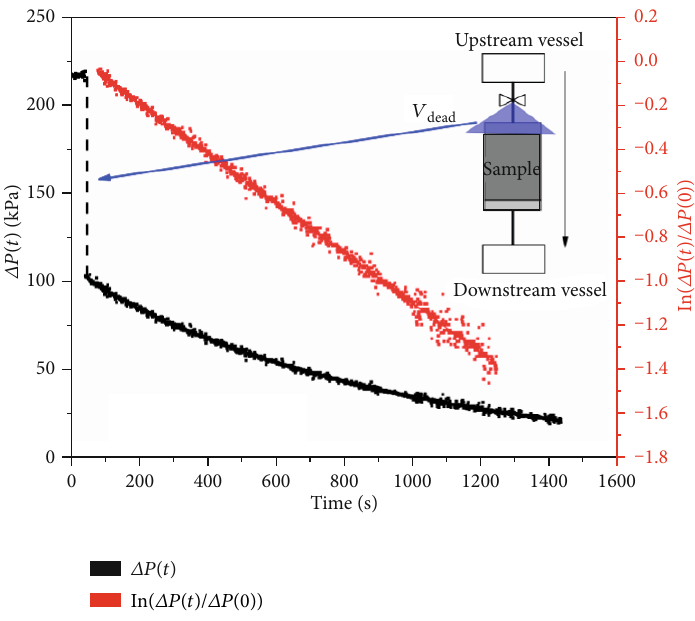
Þ − t measured in the / Δ P 0 t